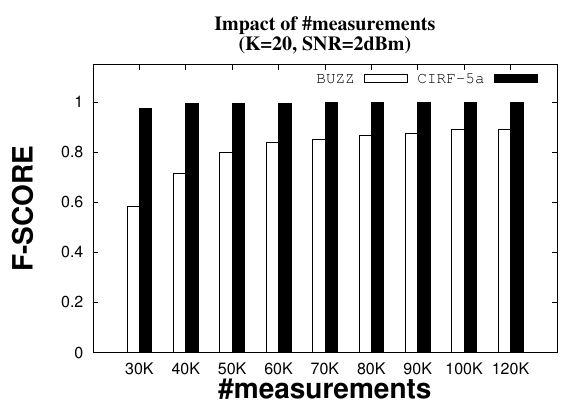
Figure 6. F-score with varying number of